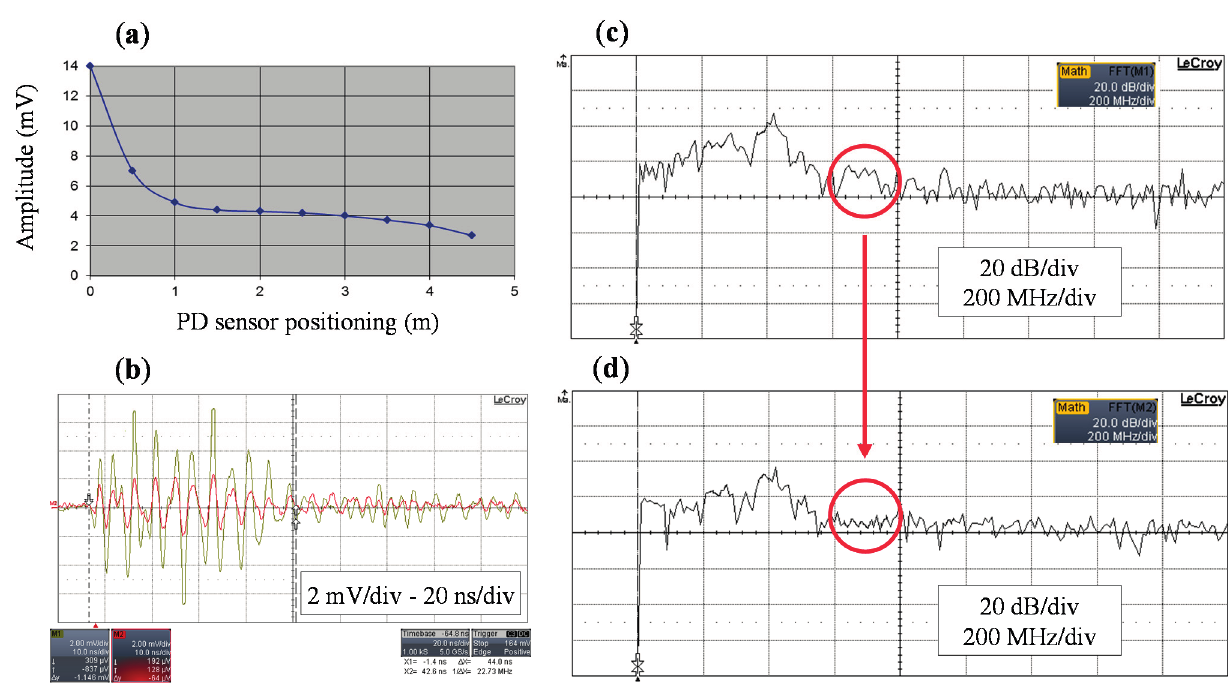
Figure 6. ( a ) PD pulse attenuation with the distance; ( b ) Superposition of a pulse measured at the beginning of the cable and at 3.5 m; ( c ) Frequency spectrum of the pulse measured at 0 m; ( d ) Frequency spectrum of the pulse measured at 3.5